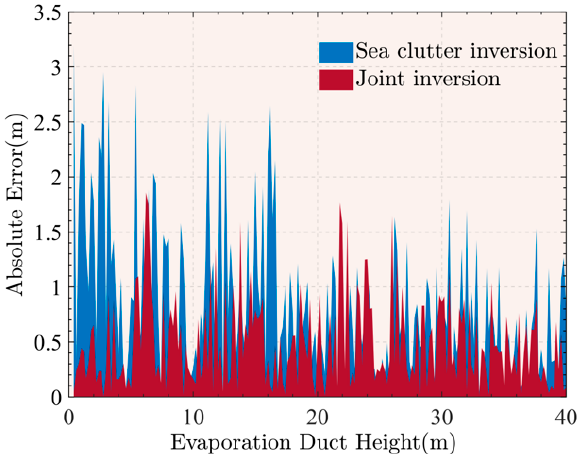
Figure 11. Absolute errors of the joint inversion method and the sea clutter inversion method.